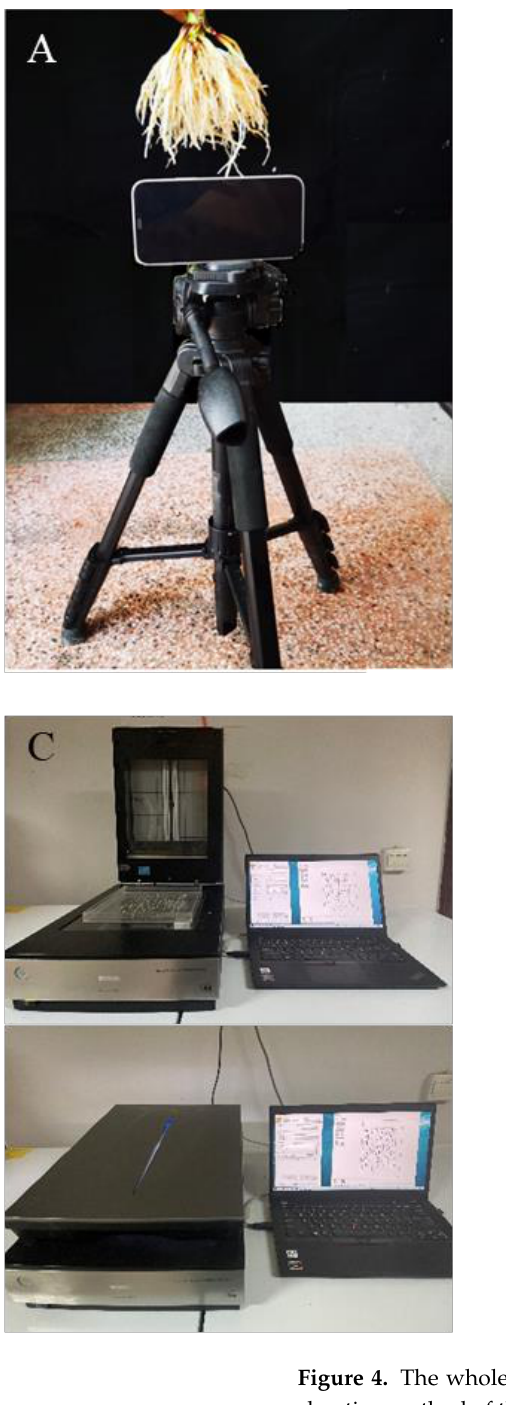
Figure 3. Maize roots were collected in the field. This method will be adopted in both Qitai and Yinchuan in 2018 and 2019. ( A ) Plant selection and shoot cutting; ( B ) Excavating fixed soil layer by layer; ( C ) Root system cleaning.